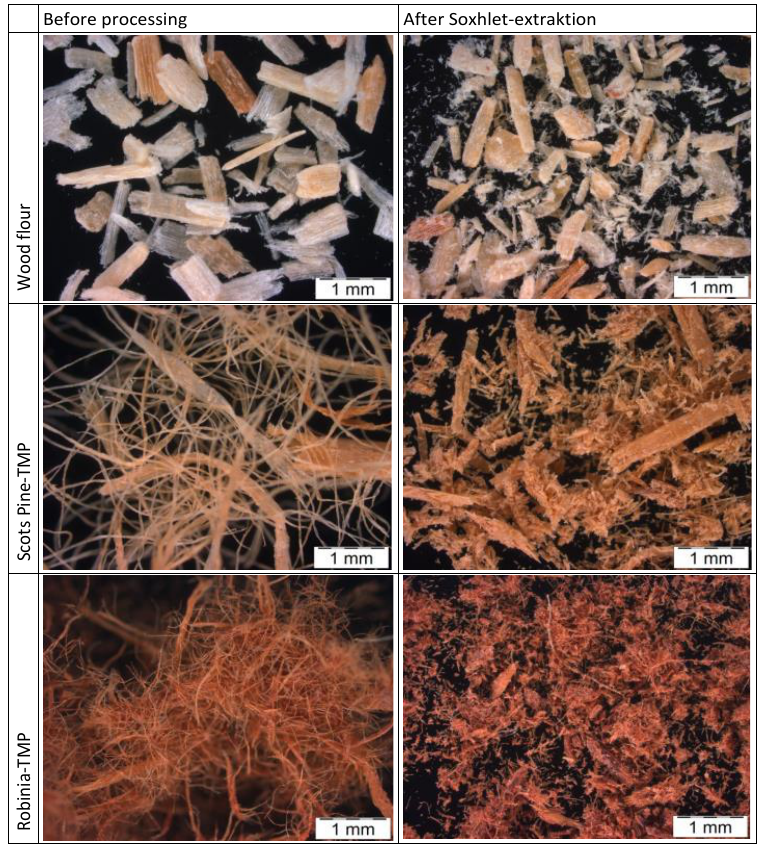
Figure 13. TMP and wood flour observed with reflected light microscope and dark field illumina- tion before compounding ( left ) and after profile extrusion followed by Soxhlet extraction ( right ). Magnification 25-fold.